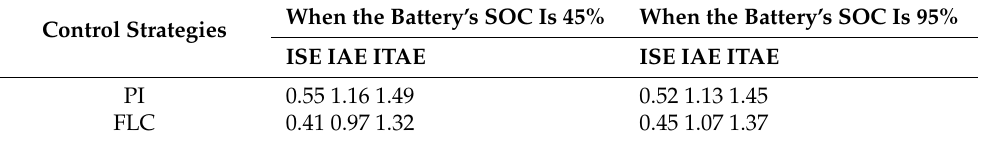
Table 9. ISE, IAE, ITAE of PI and FLC. When the Battery’s SOC Is Control Strategies